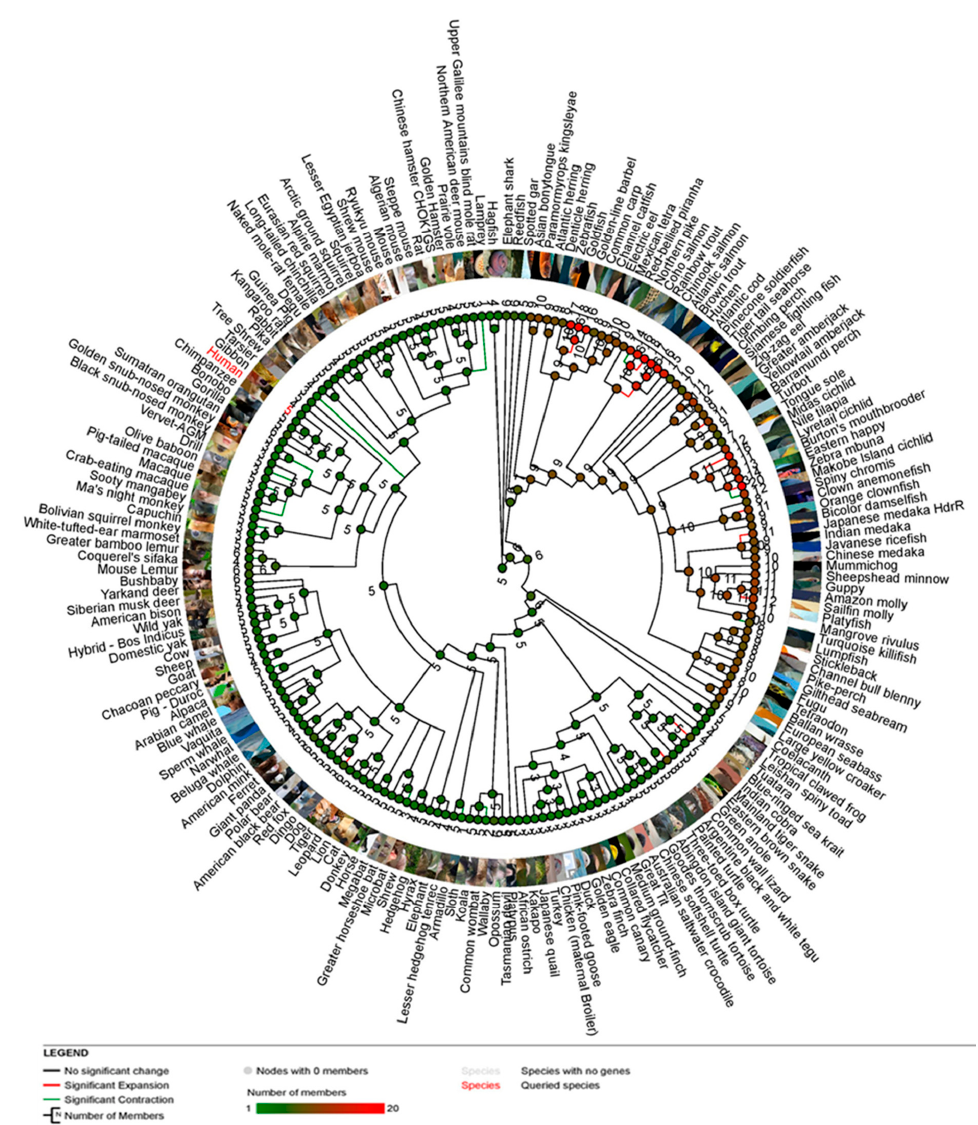
Figure 2. The evolutionary history of the CXCR4 gene is shown by the gene gain/loss tree, which highlights the genes that have been added and subtracted over time.